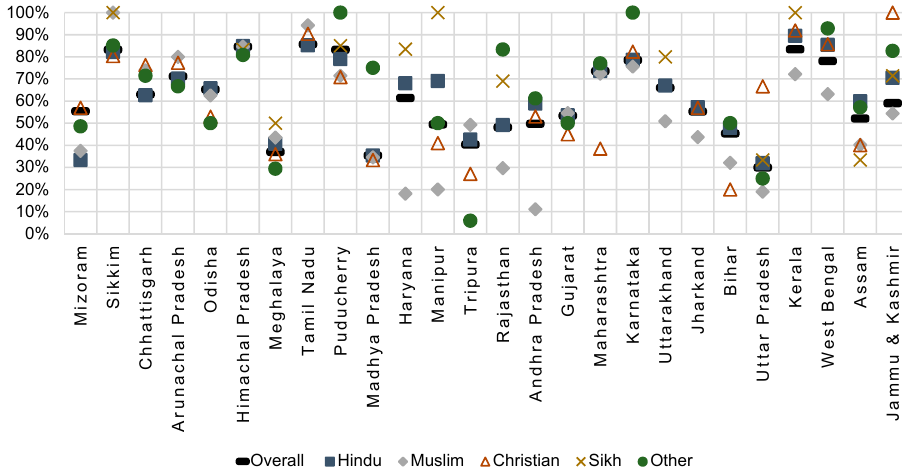
Figure 1. Percentage of fully-vaccinated children aged 12 to 36 months by religion and state of residence, DLHS3. States are ordered from lowest proportion Muslim to highest proportion Muslim.